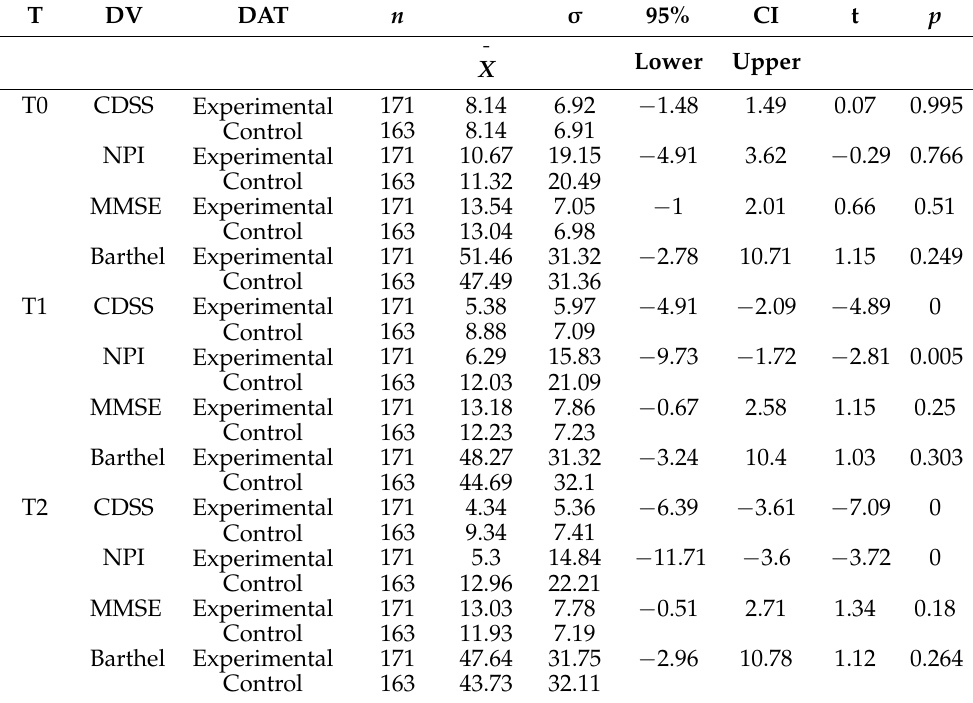
Table 3. Comparison between